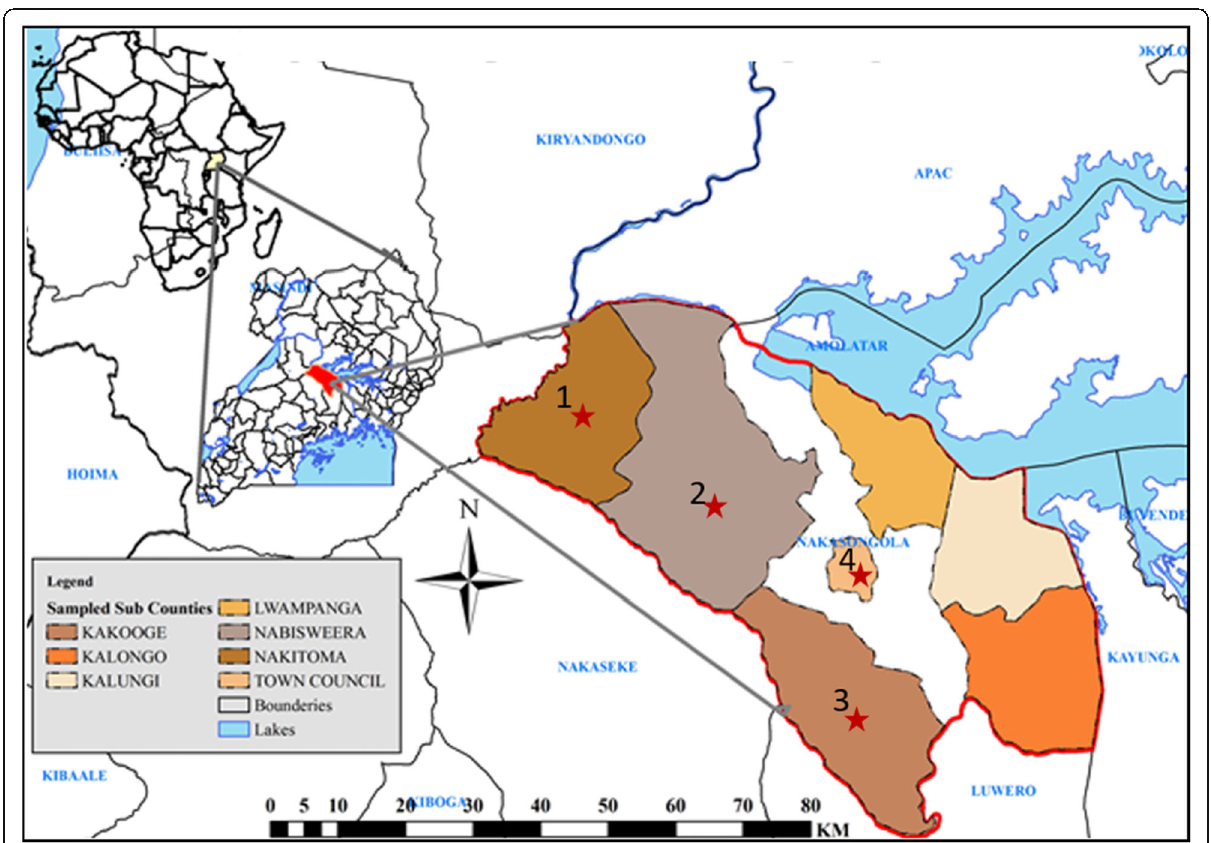
Fig. 1 Selected study sub-counties in Nakasongola district. 1, Nakitoma; 2, Nabiswera; 3, Kakooge; and 4, Nakasongola Town